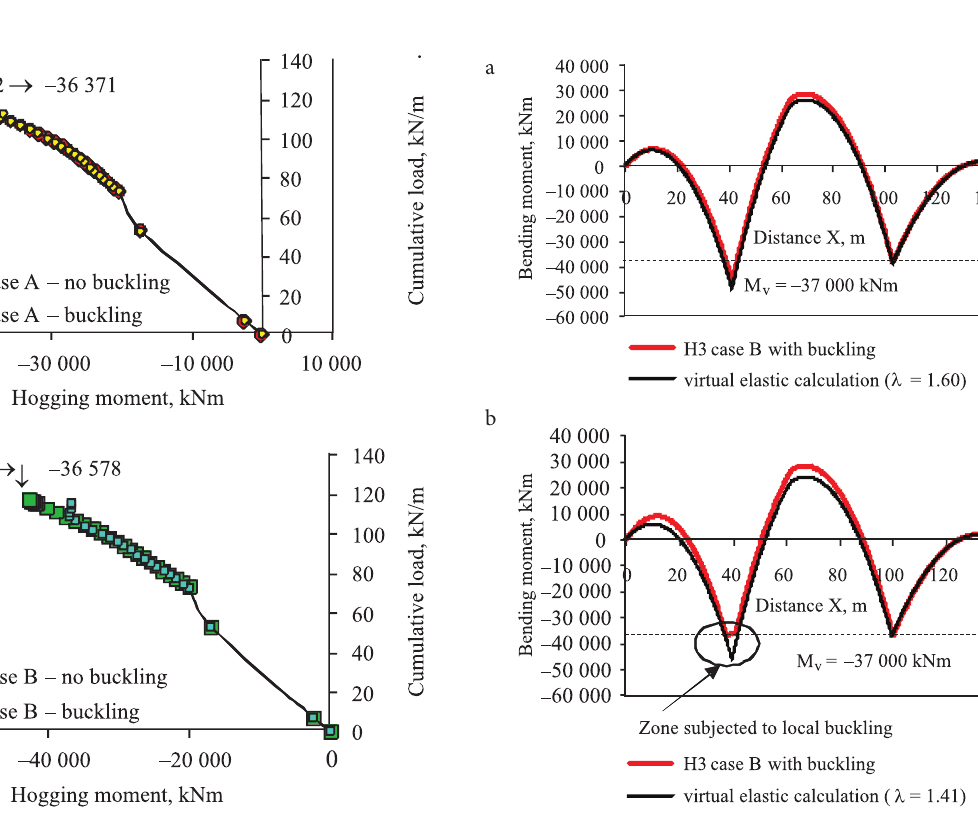
Fig. 14. (θ – M) – bean H4 case A (a) and case B (b)